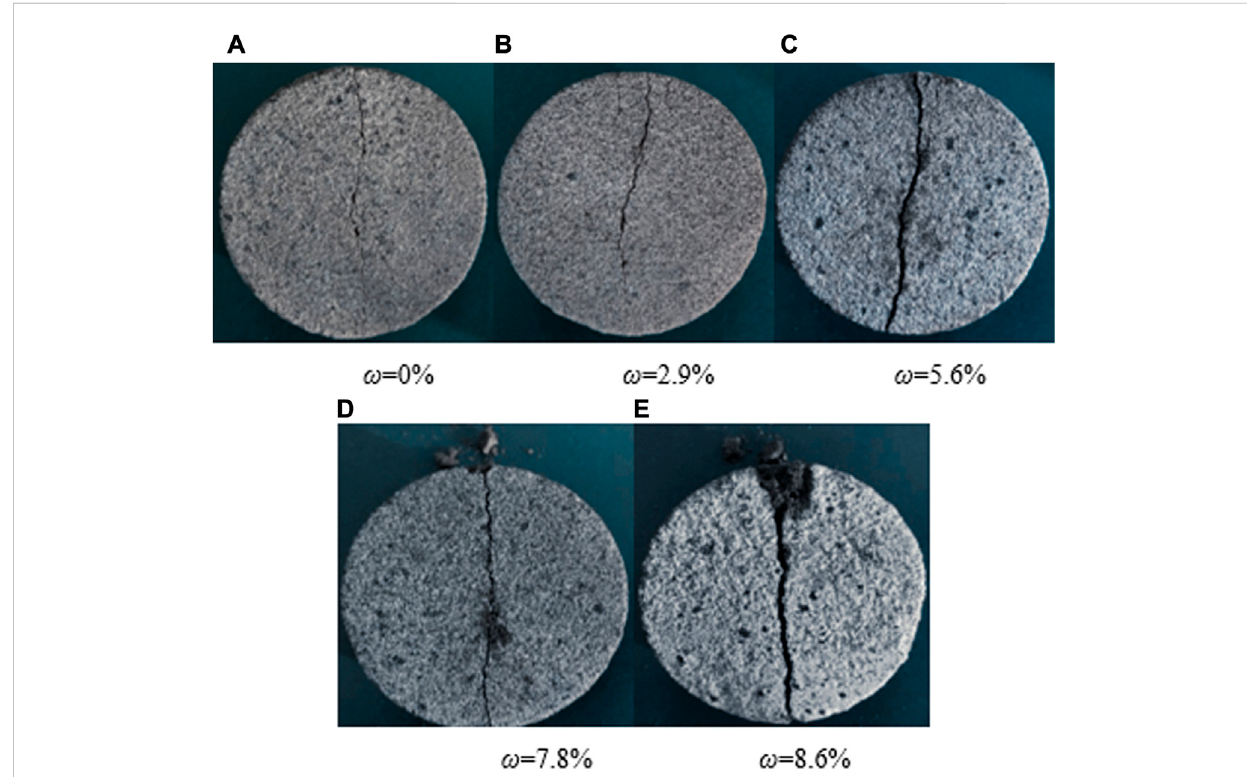
FIGURE 8 Brazilian splitting failure modes of red sandstone with different water contents. (A) ω = 0%, (B) ω = 2.9%, (C) ω = 5.6%, (D) ω = 7.8%, and (E) ω = 8.6%